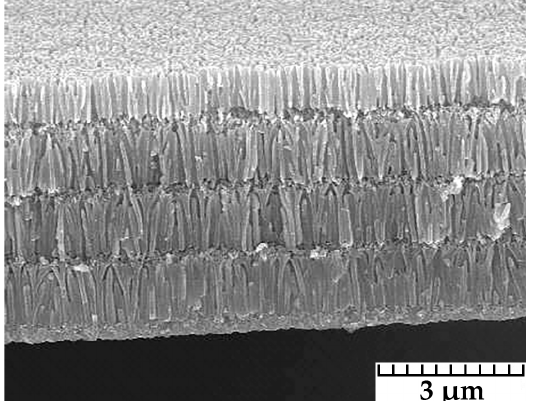
Figure 1. Cross-section of the aluminum oxide anodic film obtained in 1 M phosphoric acid at 100 V from 5 μ m Al film on a Si substrate.